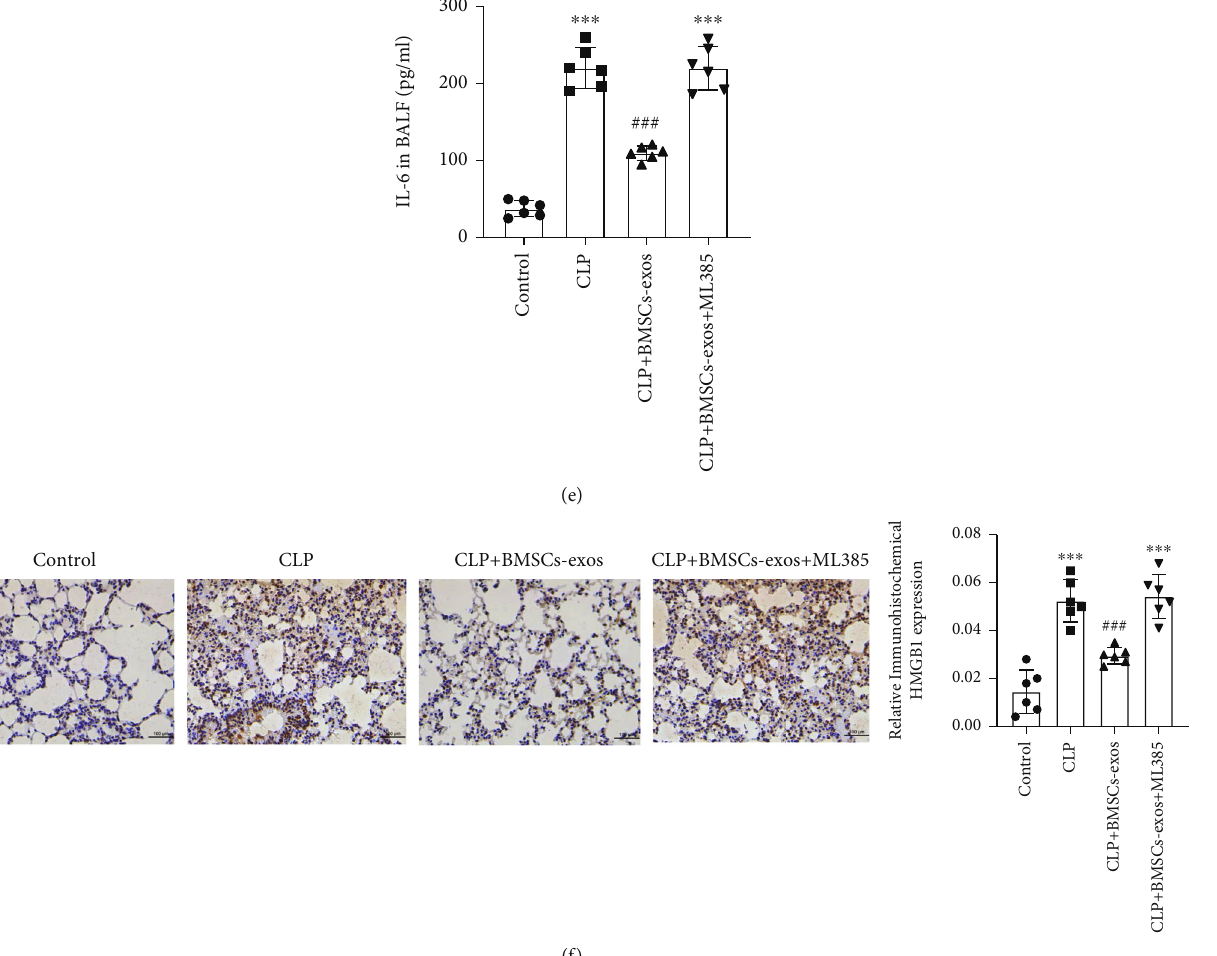
Figure 5: BMSC-exos alleviated sepsis-induced ARDS via activating the Nrf2 pathway in vivo . The randomly assigned mice were administered ML385 (30 mg/kg) intraperitoneally 2 hours before CLP surgery and injected intratracheally with BMSC-exos (300 μ g/ mouse) 1 hour before CLP surgery. (a) Survival rate of mice. (b) H&E staining of lung tissue sections. (c) Total protein concentrations in BALF. (d) Wet/dry ratio of lung tissue. (e) Levels of the IL-6 in BALF. (f) Immunohistochemistry of HMGB1 expression in lung tissue sections. Data are presented as mean ± SD , n = 6 per group. NS: nonsigni fi cance; ∗∗∗ P < 0 : 001 vs. the control group; ### P < 0 : 001 vs. the LPS group or CLP